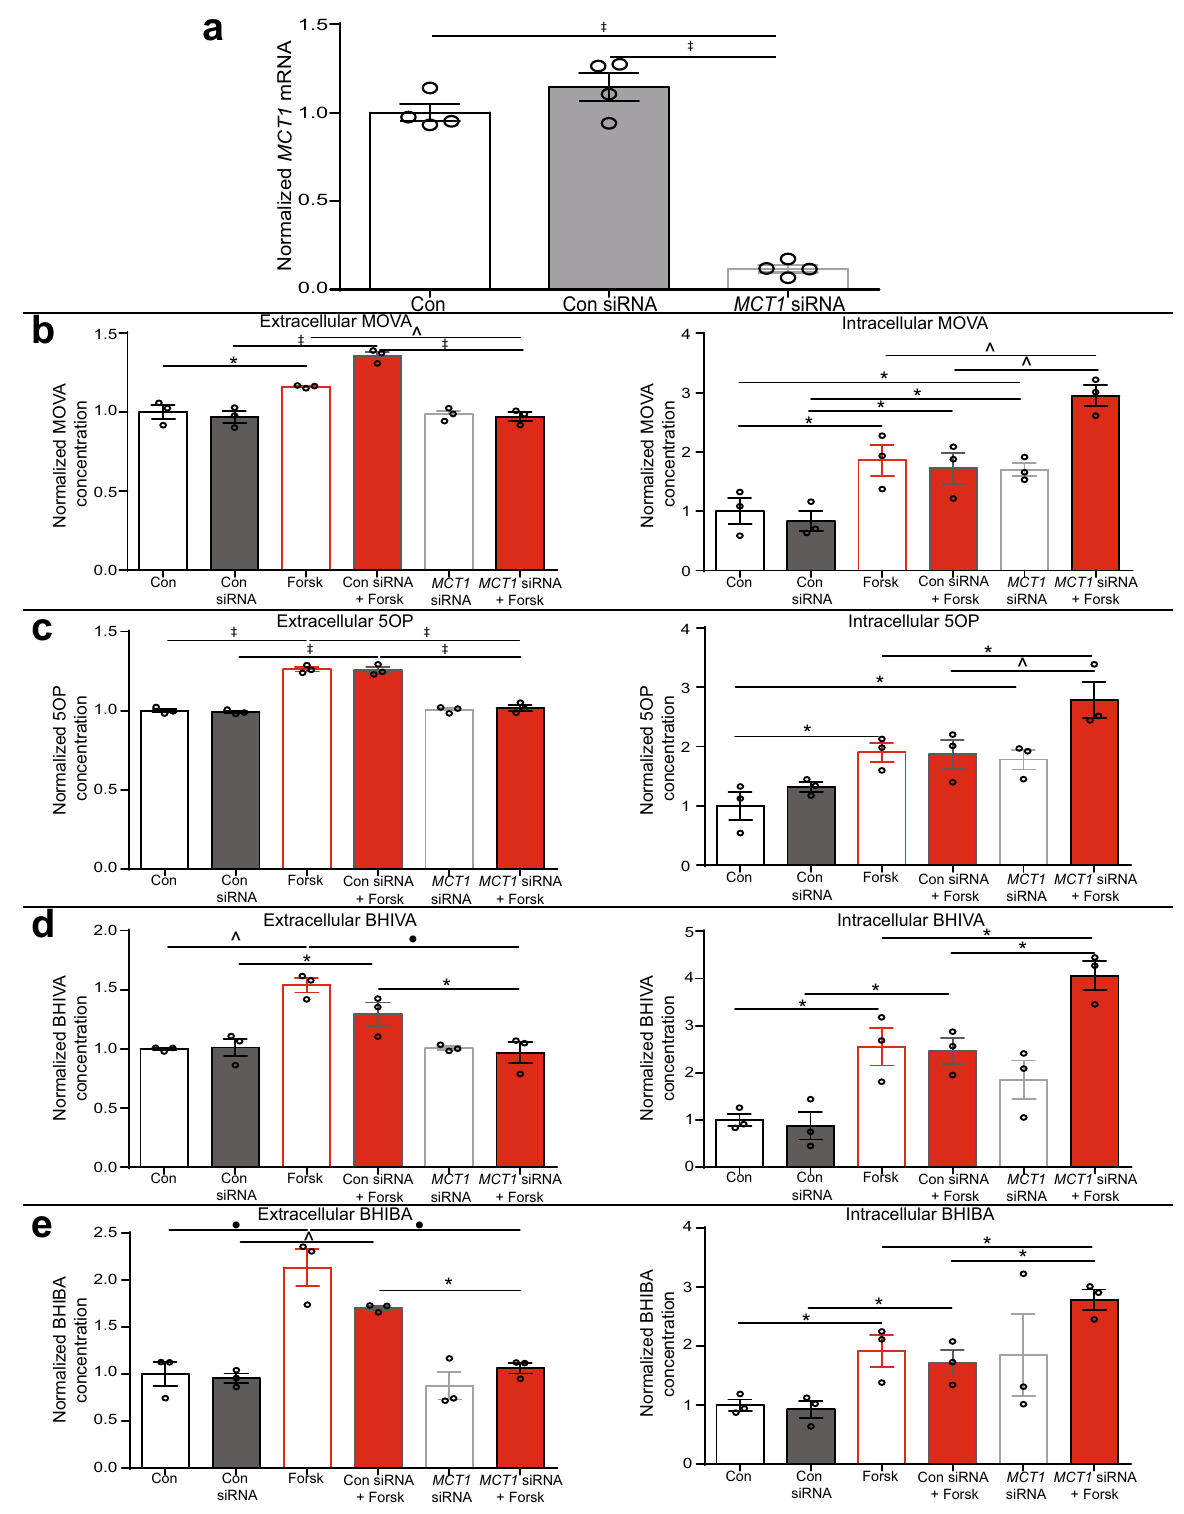
fed a 60% fat diet for 17 weeks, had greater body weight and impaired glucose tolerance compared to matched chow-fed controls (Supplementary Fig. 6g, h). Obese mice exhibited markers of whitening within their intrascapular BAT, with decreased expression of thermogenic genes (Supplementary Fig. 6i) and a white-adipocyte-like morphology (Supplementary NATURE COMMUNICATIONS| (2021) 12:1905